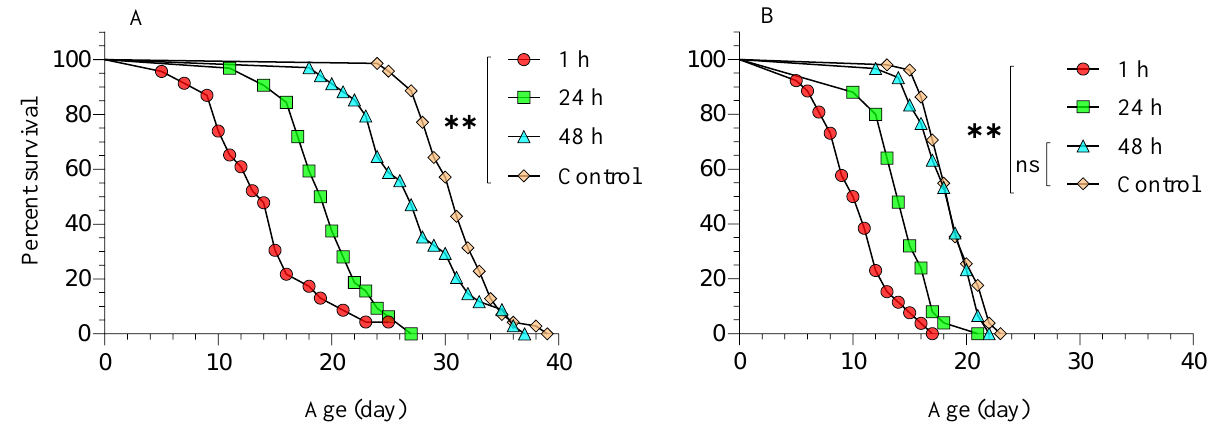
Figure 2. Survival rate for females ( A ) and males ( B ). Survival curves of Tamarixia radiata by log-rank analysis were generated where Diaphorina citri nymphs were first parasitized by Tamarixia radiata and subsequently treated with Beauveria bassiana (BB-12) (Females n = 23, 32, 34 and 70 at 1 h, 24 h, 48 h and control, respectively) (Males n = 26, 25, 30 and 51 at 1, 24, 48 h and control, respectively). (** p < 0.001).